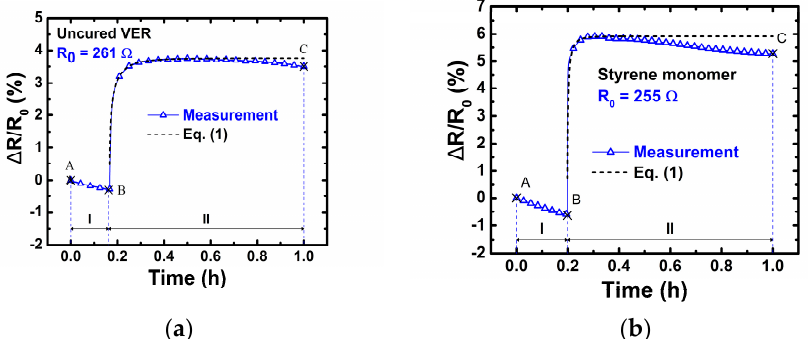
Figure 7. Fractional change of electrical resistance of CNTY versus elapsed time for CNTY immersion into two liquid components of VER: ( a ) uncured VER without initiator or promoter and ( b ) styrene monomer.